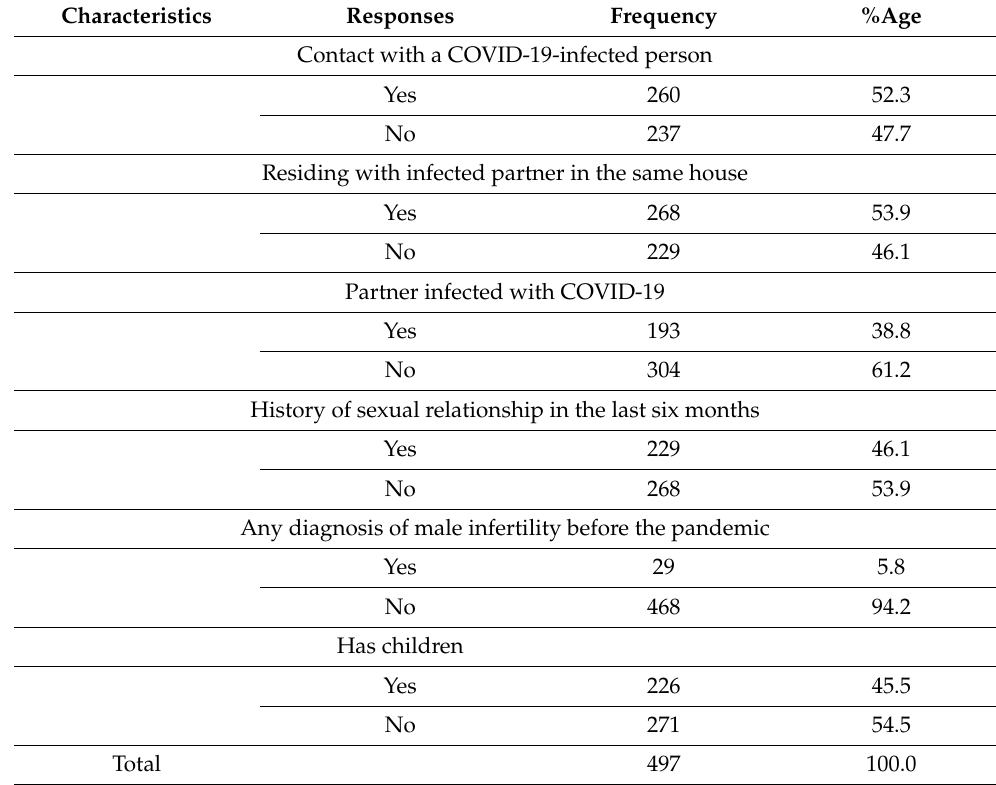
Table 3. COVID-19 and partner relationship reported by responders during the pandemic lockdown. ( n =